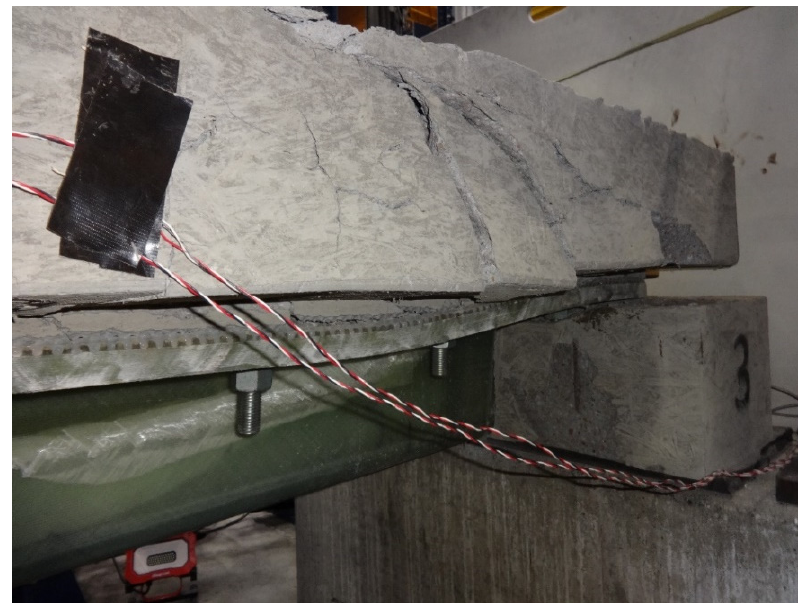
Figure 15. Post-Failure Image of Beam B1.